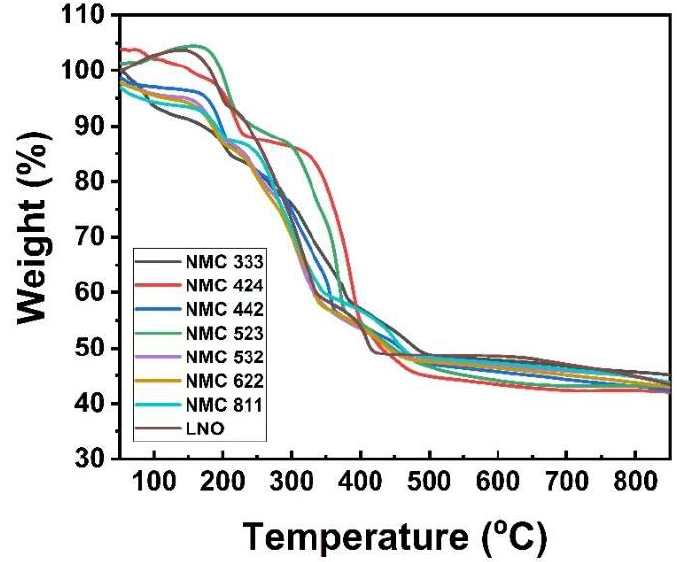
Figure 6. Thermal analysis of LNO and NMC at various compositions.